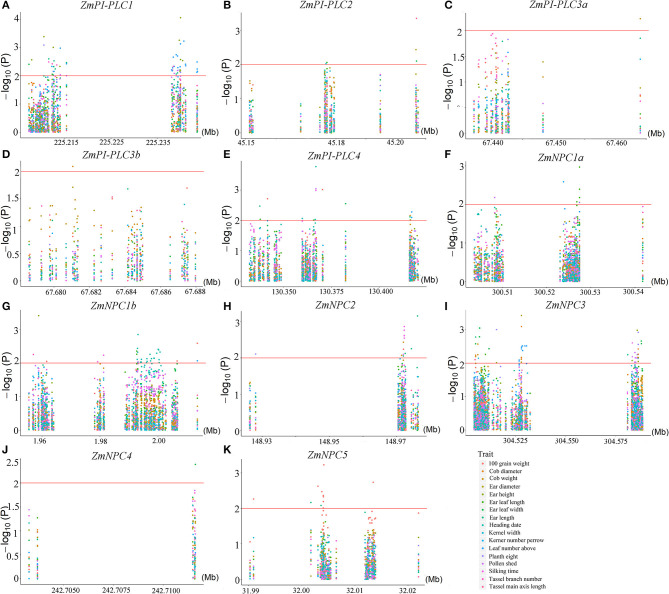
Regional correlation analysis between ZmPLC genes with the agronomic traits in maize. (A–K) show the correlation between ZmPLC genes with the agronomic traits, respectively. Local Manhattan plot (top) and linkage disequilibrium heatmap (bottom) surrounding the SNPs for agronomic traits on the range of 100 kb upstream/downstream of ZmPLC genes. An logarithm of the odds (LOD) > 2 indicates that a SNP is significantly related to kernel-related traits.